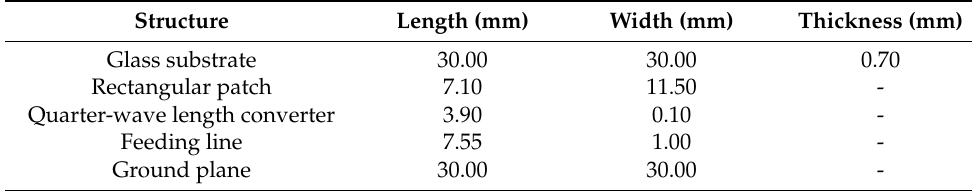
Table 1. Dimensions of the proposed glass antenna.